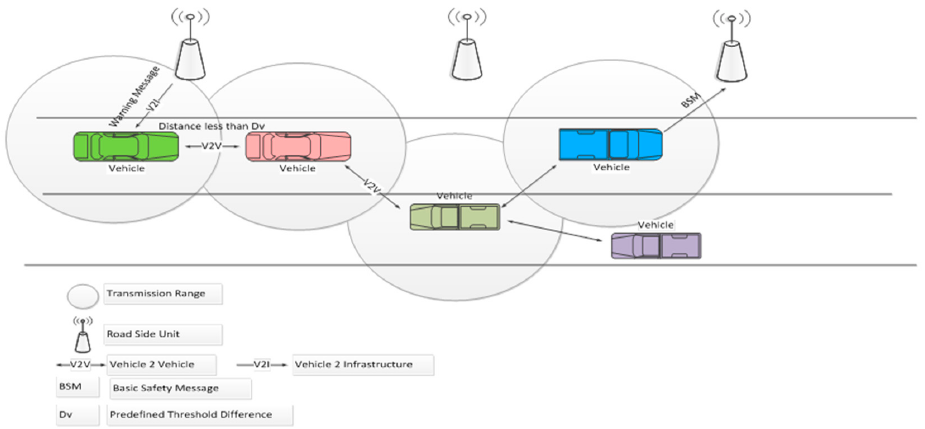
Sensors 2018 , 18 , x FOR PEER REVIEW 12 of 24 Figure 3. Illustration of Traffic Accidents Reduction Strategy (TARS). Figure 3. Illustration of Traffic Accidents Reduction Strategy (TARS).